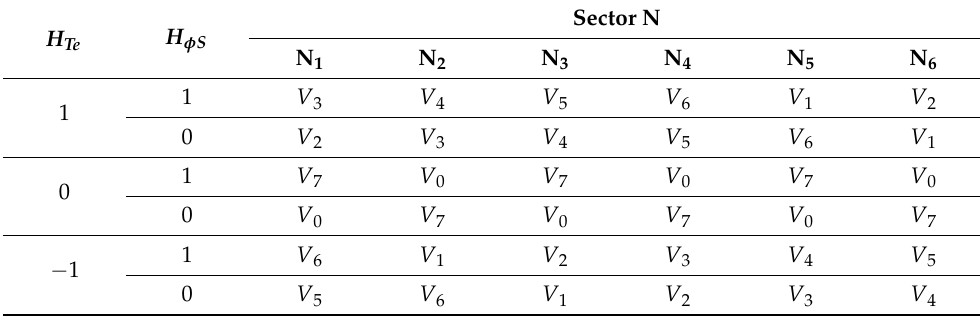
Table 4. Switching table of DTC